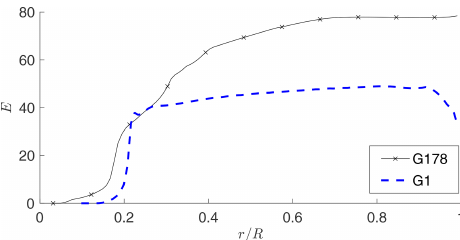
Figure 2. Efficiency E along the blade span r/R for the G178 and G1 turbines at rated